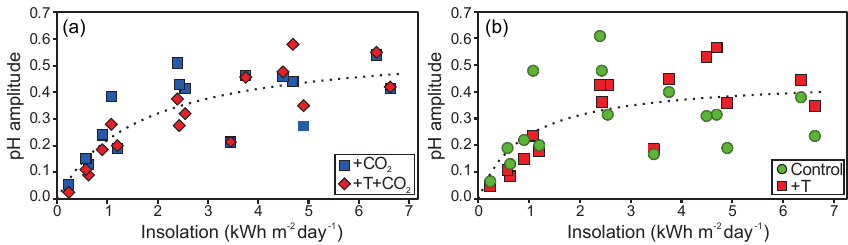
Figure 4. Light dependence of diurnal pH cycles. Average diurnal pH amplitudes in the benthocosm basins for CO 2 -enriched (a) and ambient (b) treatments plotted versus the average daily insolation (as in Fig. 3) for the sub-periods of the four seasonal experiments. Dotted lines are Michaelis–Menten fits to the data, y = A · x/(B + x) , with rate constants ( A ) of 0.5 and 0.6 and half-saturation constants ( B ) of 0.9 and 1.6, for ambient and CO 2 -enriched treatments